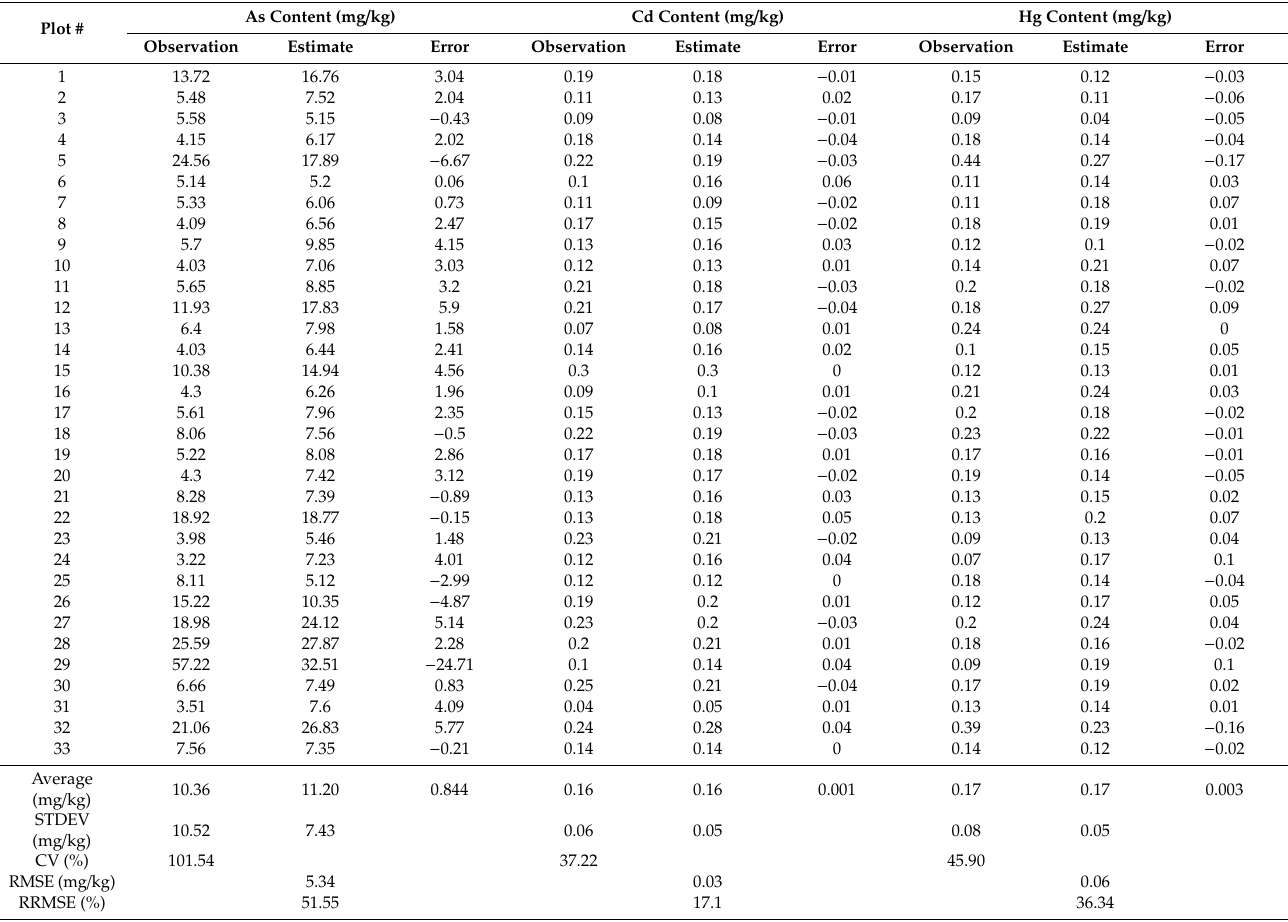
Table 5. Accuracy assessment of predicted soil heavy metal contents by comparing the estimates using the models and the HJ-1A data with the field observations based on 33 test sample plots (confidence intervals of As, Cd, and Hg are 6.77–13.95 mg / kg, 0.14–0.18 mg / kg, and 0.14–0.19 mg / kg, respectively; Stdev: